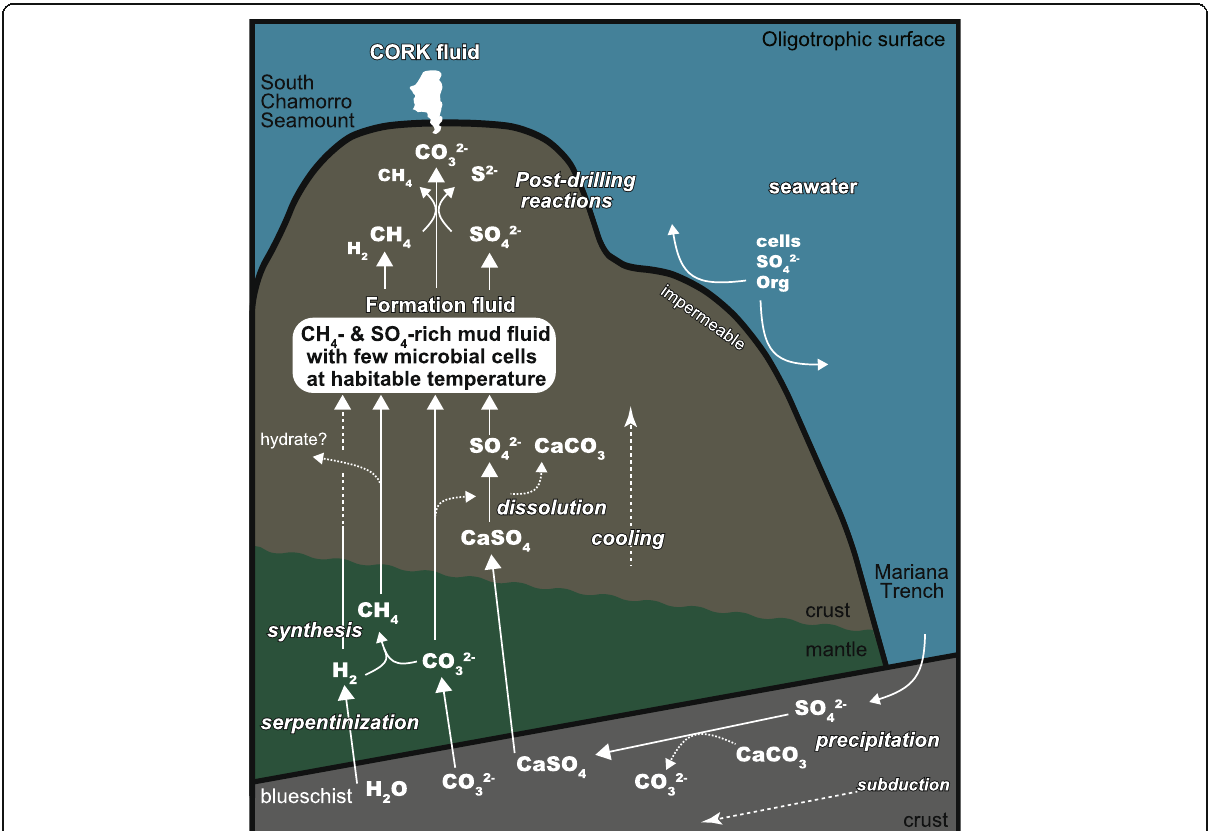
Fig. 7 Illustration for possible C-S-H reactions beneath the SCS. “ Cells ” represents microbial cells and “ Org ” represents organic matter in the